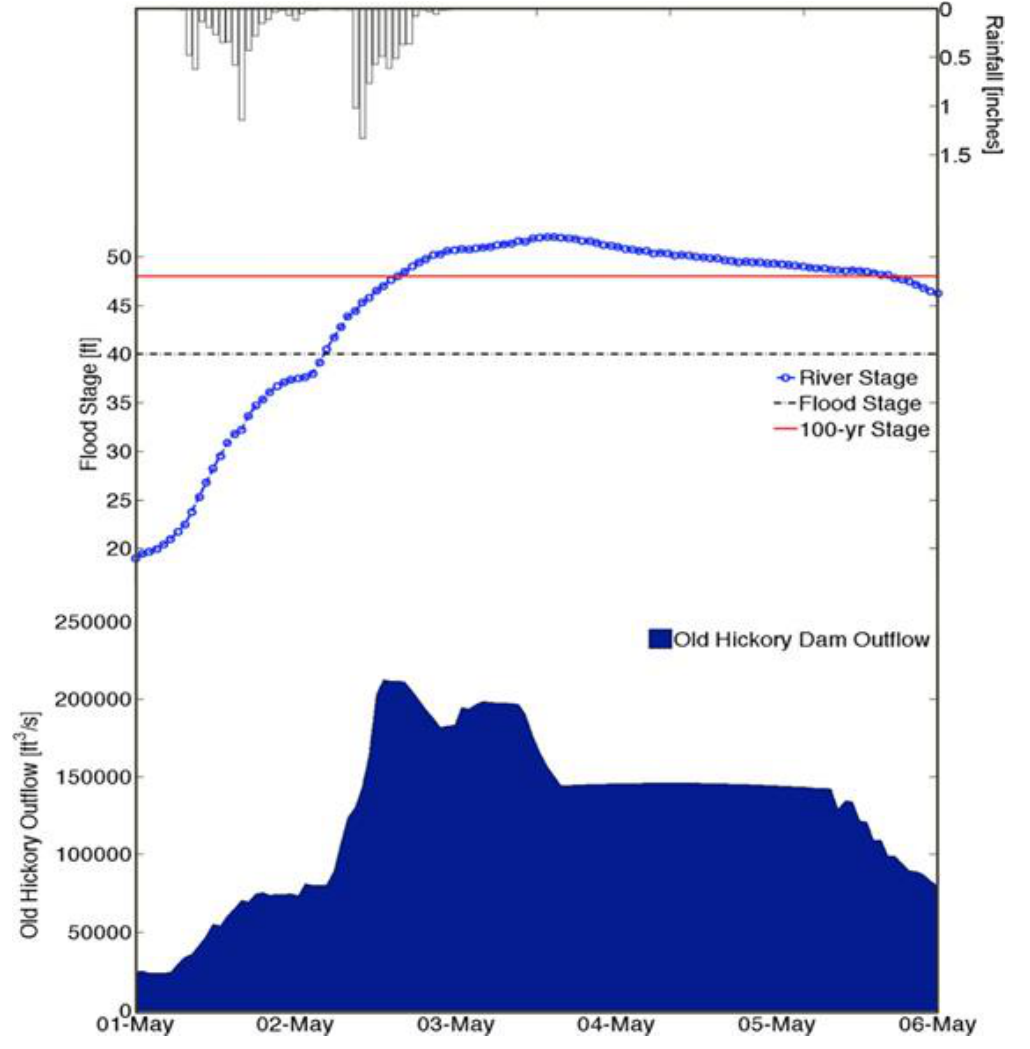
Figure 4. Discharge at the Old Hickory Dam, and flood stage at the Nashville, TN, USA gage as a function of time during the 29 April – 7 May 2010 event. [21].